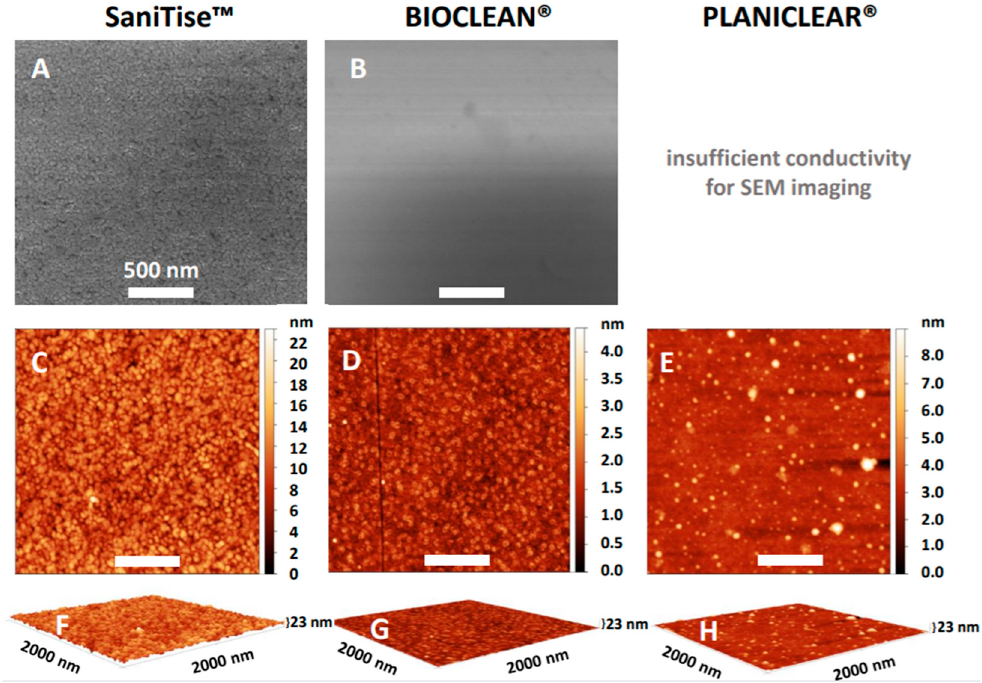
Figure 1. SEM ( A , B ), AFM ( C – E ), and AFM 3D ( F – H ) images of SaniTise TM , BIOCLEAN ® , and PLANICLEAR ® (control glass). The Z-scales on all 3D images are stretched four times relative to the X and Y scales to emphasize surface features. All scale bars correspond to 500 nm.